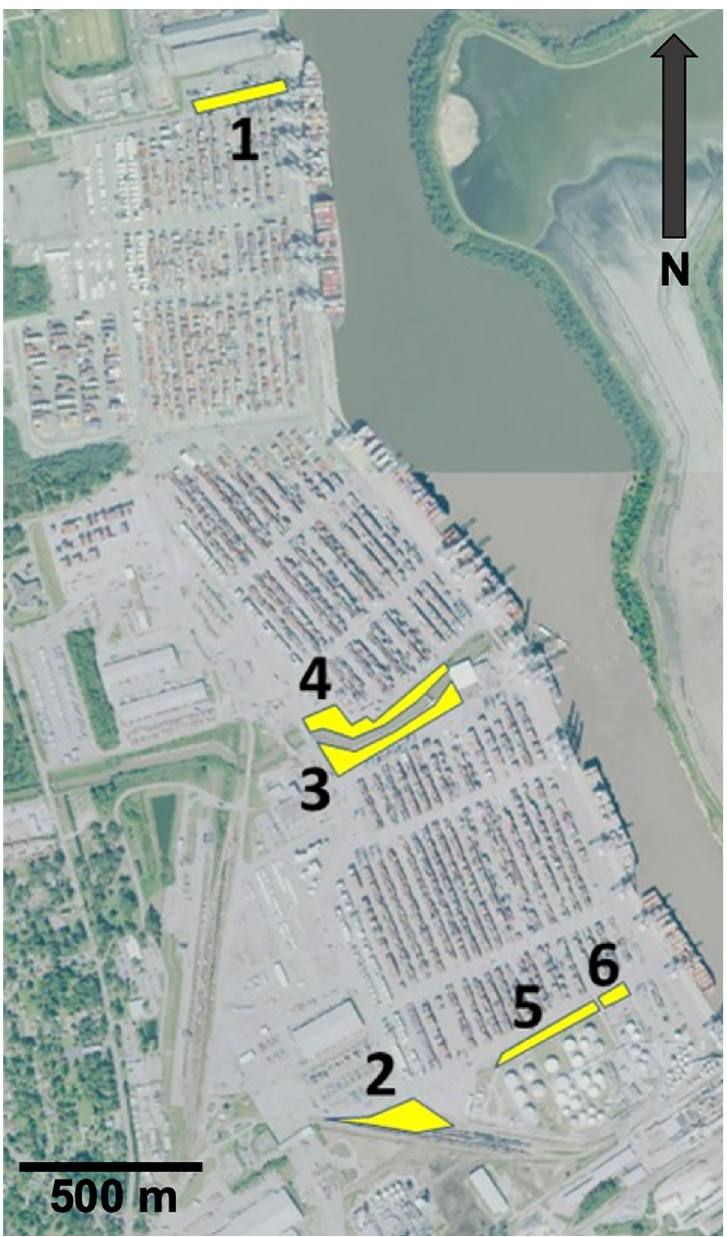
Fig 3. The Garden City Terminal (GCT) at the Port of Savannah, Georgia, USA. Yellow highlighted areas were inventoried. The base map from USGS National Map Viewer (http://viewer.nationalmap.gov/viewer/) is the USGS The National Map: Orthoimagery. Data refreshed April,